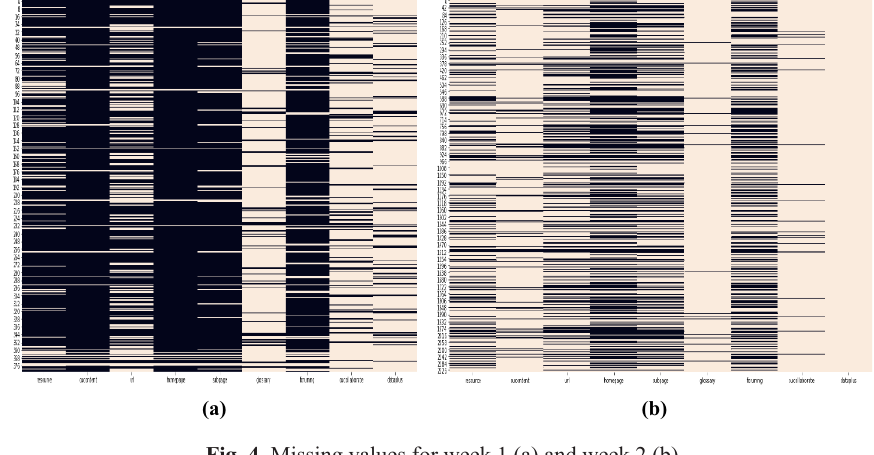
Fig. 4. Missing values for week 1 (a) and week 2 (b)